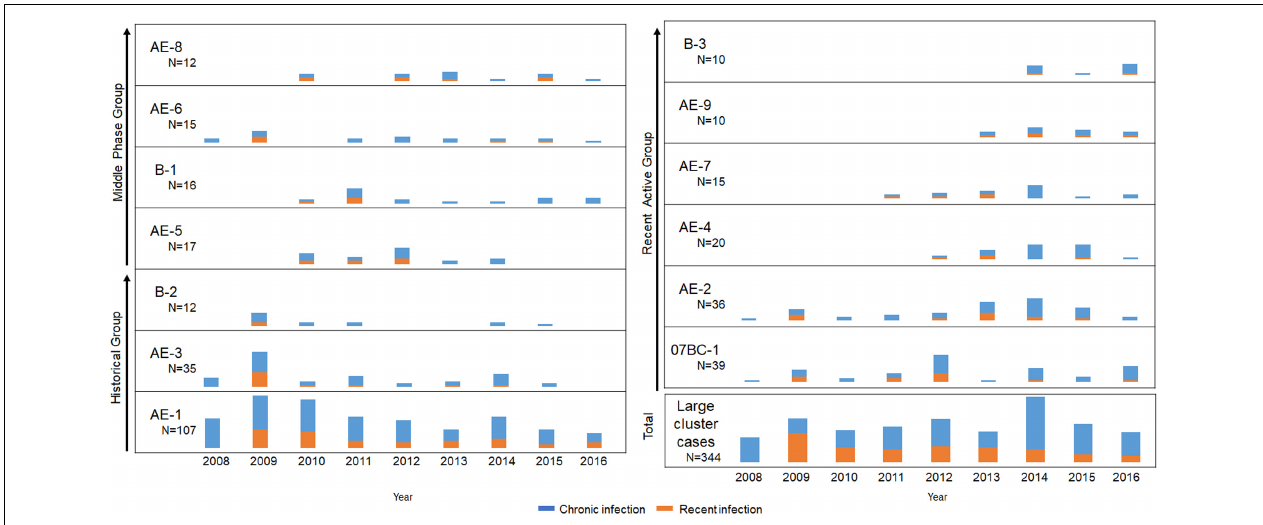
FIGURE 3 | Expanding dynamics of the three groups including 13 local large clusters ( ≥ 10 cases) from 2008 to 2016. Years are shown along the x -axis and the number of new diagnoses for each cluster or all large clusters ( ≥ 10 cases) is shown along the y -axis. Orange and blue columns indicate recent and chronic HIV infection, respectively.